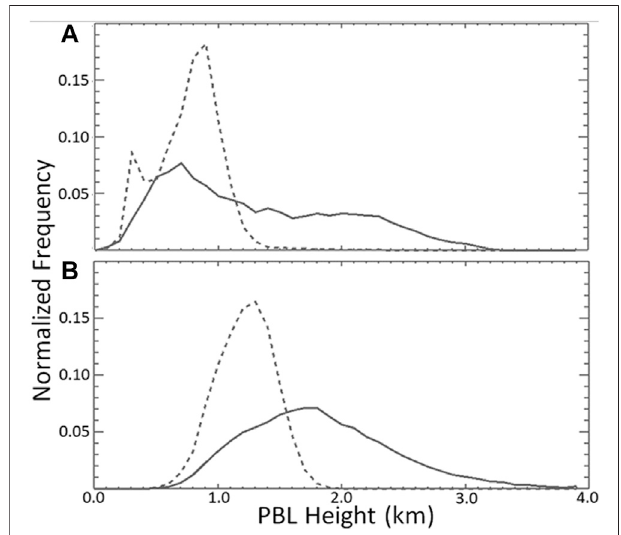
normalized probability distribution for 14:00 local time, January – December 2019. (B) Same as (A) except for all ICESat-2 PBLH